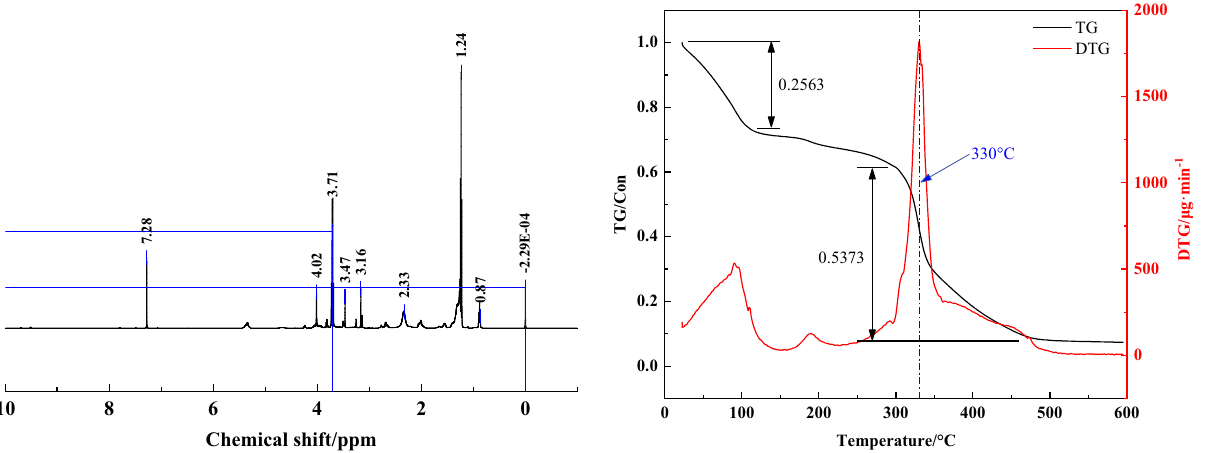
Figure 4: 1 H - NMR analysis of emulsi fi er nano - SiO 2 @OBQA. Figure 5: TG and DTG analysis of nano - SiO 2